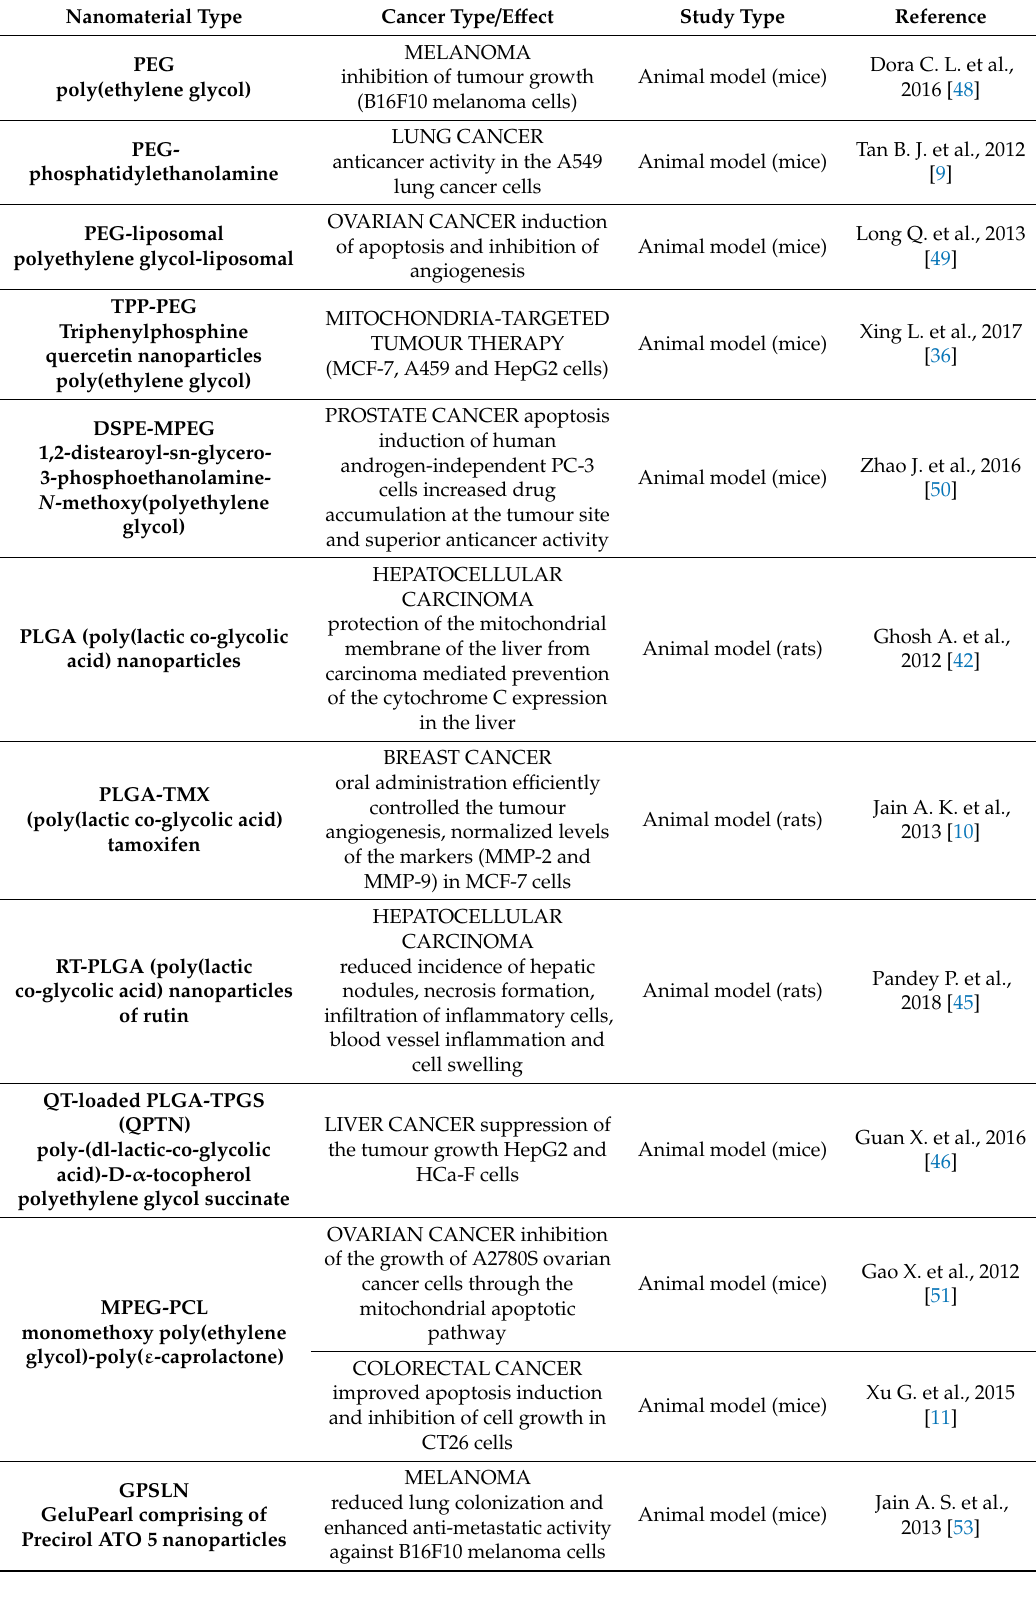
Table 2. Anticancer e ff ect of quercetin (QT) nanoparticles in in vivo